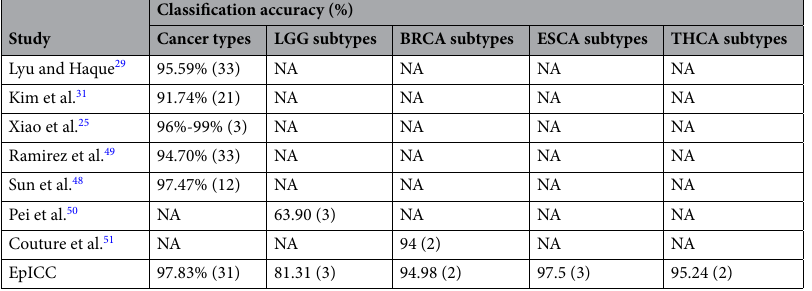
Table 1. Accuracy of EpICC for classification of cancer types and sub-types in comparison to published methods. The number within the brackets show the number of cancer types or subtypes for which classifications were